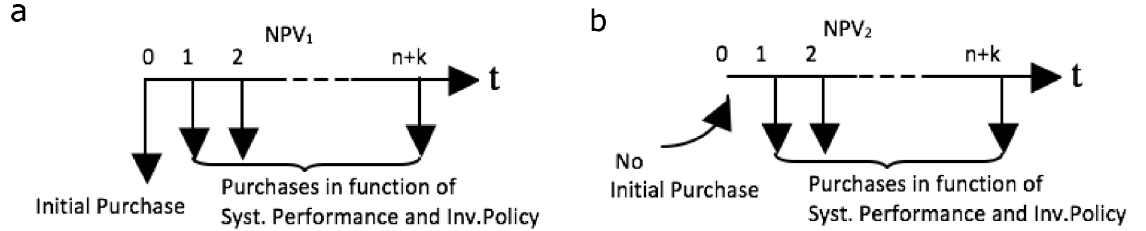
Figure 1. The effects of Initial Provisioning in Cash